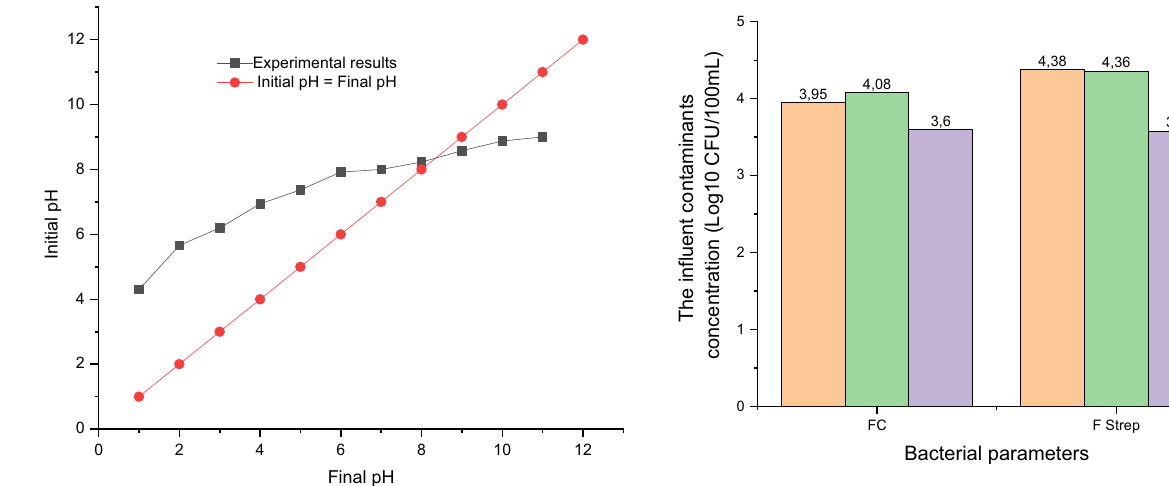
Fig. 5 pH PZC of Kenadsa’s natural green clay (Bechar-Algeria)